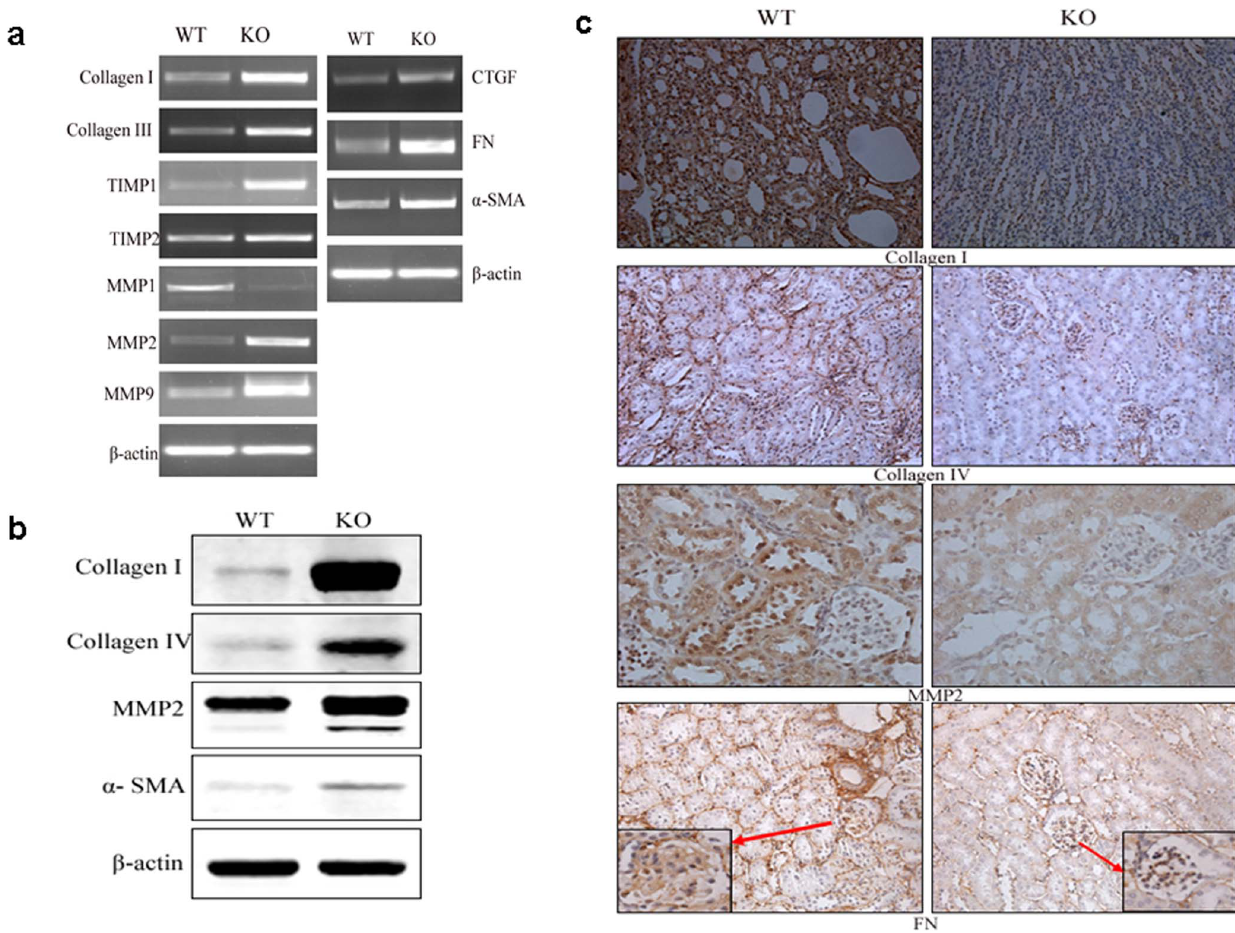
Figure 3. Abnormal expressions of extracellular matrix proteins in the kidneys of Gpr48 KO mice. Some important fibrotic markers are highly expressed in the Gpr48 KO mice compared with the WT mice. (a) Total RNA was extracted and analyzed for the expression of collagenI, III, IV, MMP1,2,9, TIMP1,2 CTGF, FN and alpha-SMA in the kidneys by RT-PCR. (b) Western blot analysis depicted protein level of collagenI, IV, MMP2 and alpha-SMA in the kidneys of mice. (c) The expression of collagen I, IV, MMP2 and FN proteins was studied by immunohistochemistry on Gpr48 KO and WT adult mice (Magnification, 400 6 ).